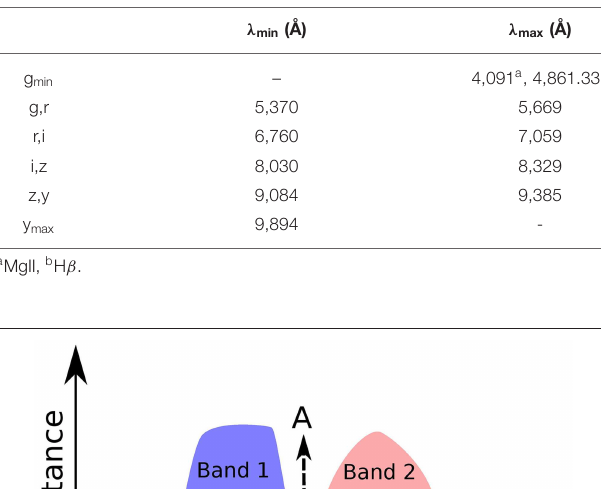
TABLE 2 | LSST photometric bands: overlapping windows.